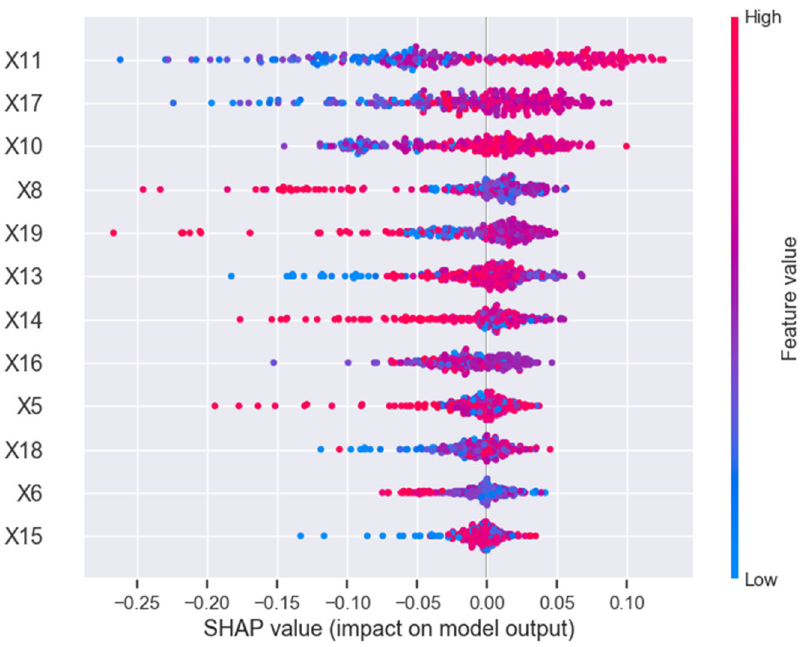
Figure 6. Example plot of SHAP values for one iteration of the model evaluation process for the CatBoost algorithm.